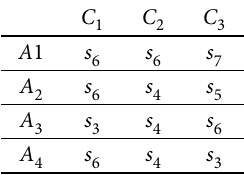
Table 1. Linguistic decision matrix X 1